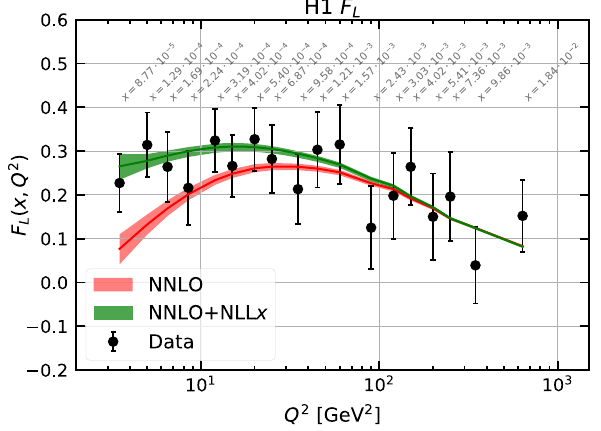
Fig. 8 The H1 extraction of F L compared to the predictions with and without ln ( 1 / x )